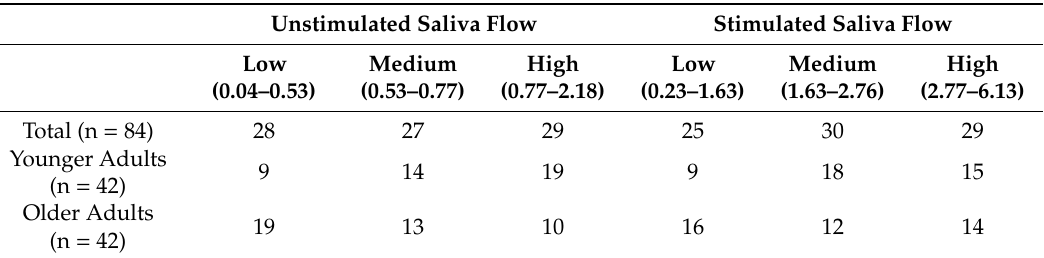
Table 3. Summary of volunteers salivary flow rates categories 1 (ml / min).